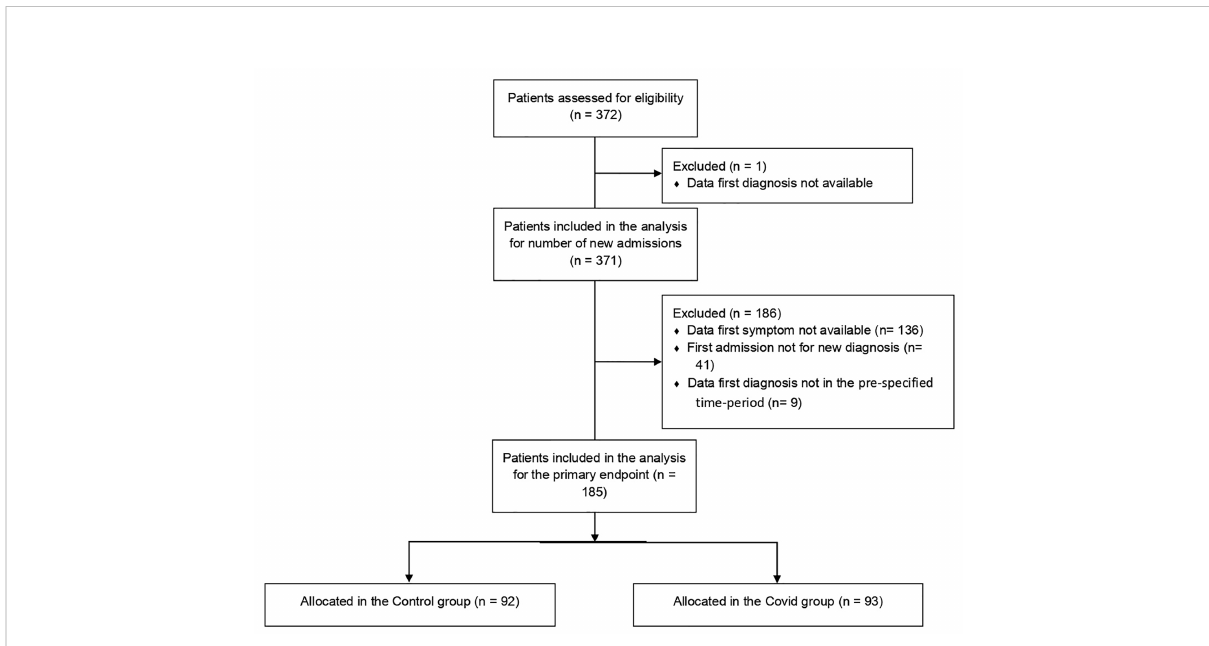
FIGURE 1 Consort diagram of patients included in the study. A total of 372 patients were selected from the EURACAN database, of whom 371 were eligible for secondary endpoint analysis of the number of new admissions. After exclusion of 186 patients not eligible for primary endpoint analysis, we included in the fi nal analysis 185 patients, of whom 92 were in the Control group and 93 were in the Covid